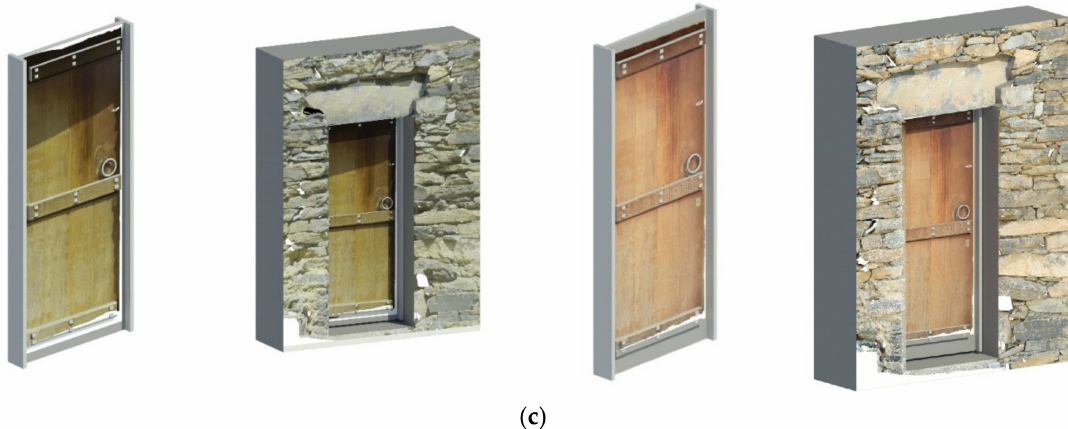
Figure 23. ( a ) True orthophoto (1 mm GSD) using TLS Camera (left) and independent Canon Camera (right), the occluded areas in white; ( b ) warping the orthoimage to the corresponding surfaces in Revit environment; ( c ) As-Texture HBIM using true orthophotos.